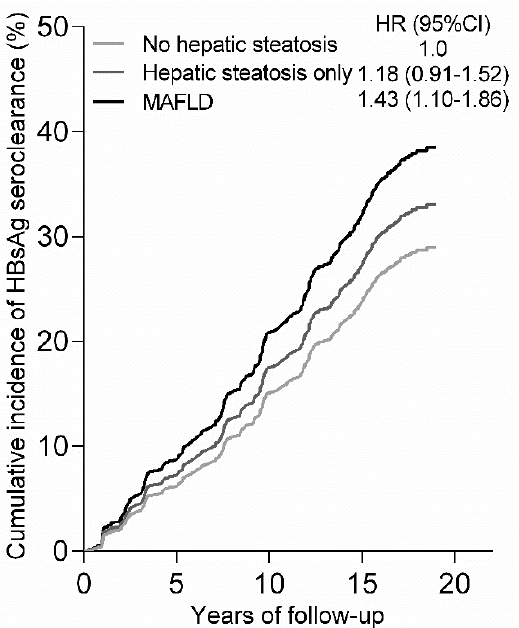
Figure 2. Cumulative incidence of HBsAg seroclearance. Cumulative incidence function was de- rived from a Cox’s model adjusted for age at recruitment.